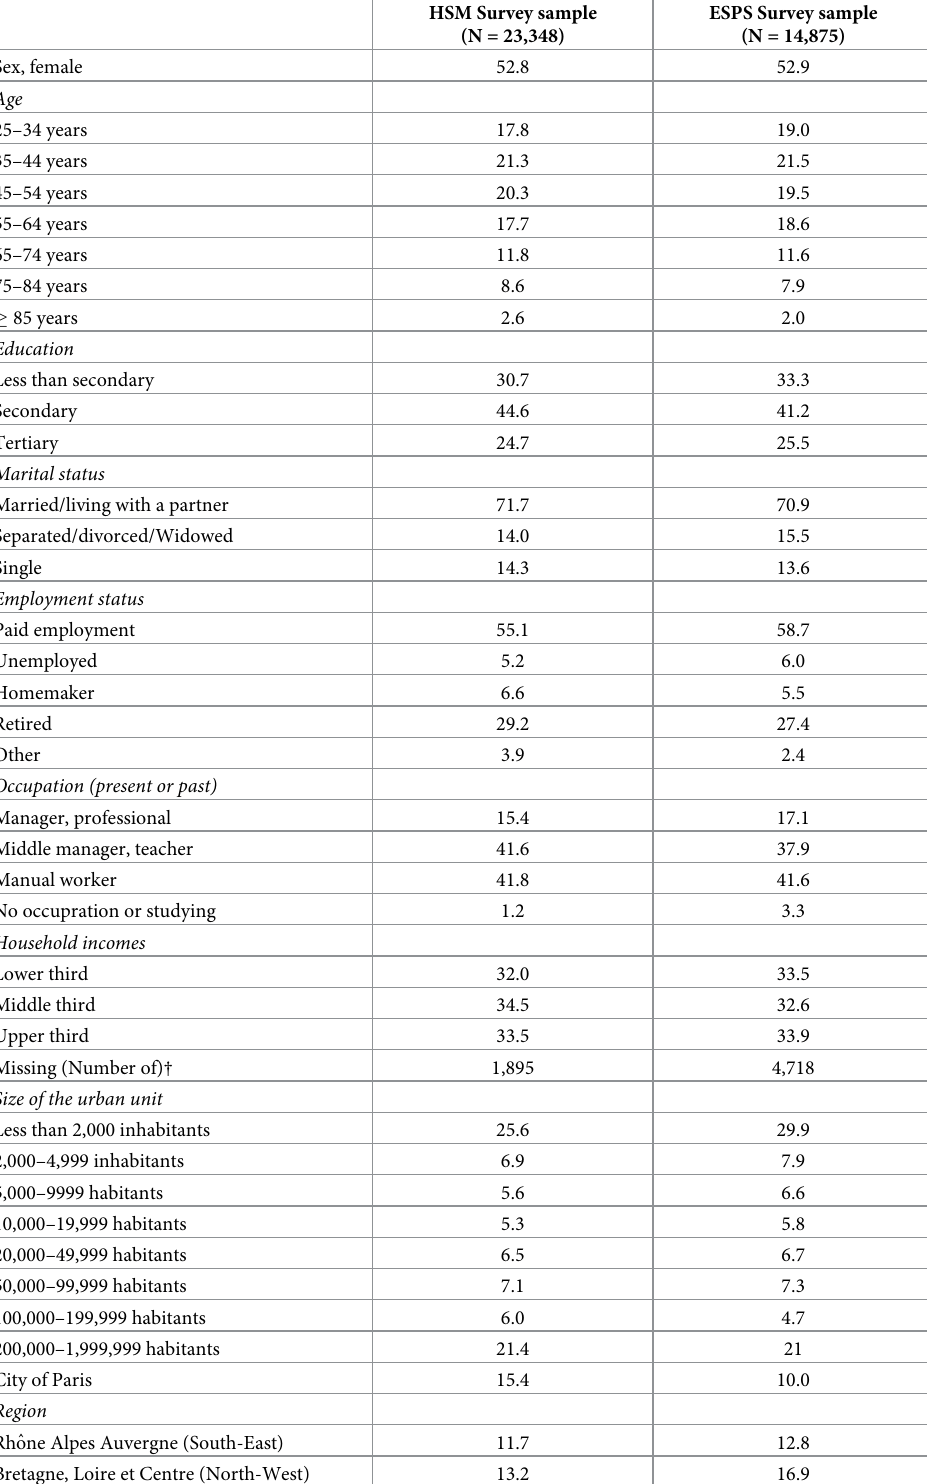
Table 1. Description of the samples studied (ESPS and HSM surveys). All figures are weighted percentages unless otherwise